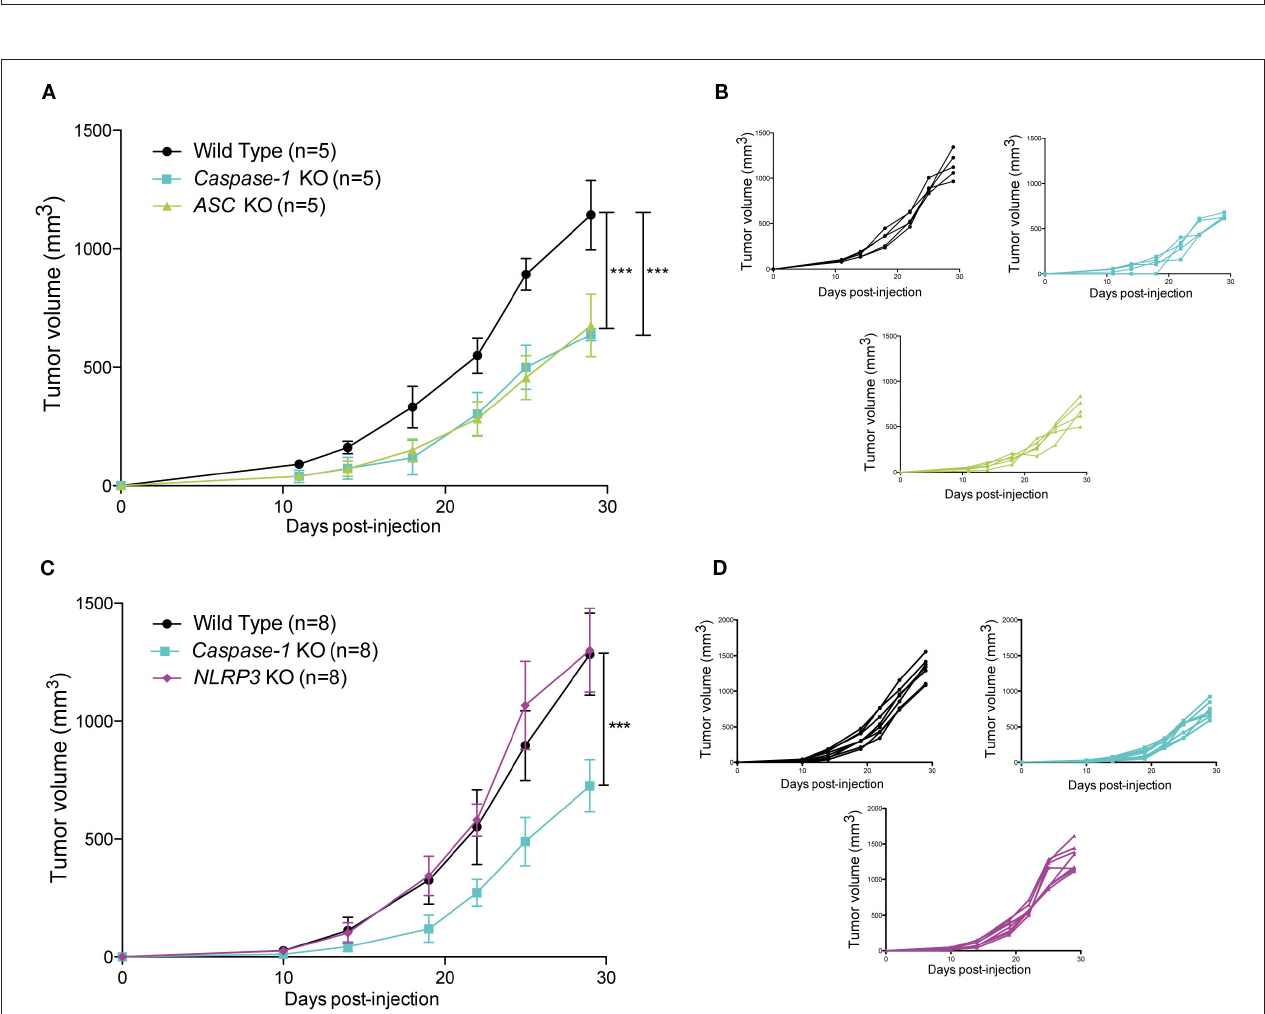
FIGURE 2 | Loss of caspase-1 and ASC expression reduces 4T1 tumor growth in BALB/c mice. (A) WT, Caspase-1 KO, and Asc KO mice ( n = 5) were injected orthotopically with 4T1 mammary tumor cells. Tumor growth was measured over 30 days. (B) Individual growth curves depicted in A. (C) WT, Caspase-1 KO, and Nlrp3 KO mice ( n = 8) were injected orthotopically with 4T1 mammary tumor cells. Tumor growth was measured over 30 days. (D) Individual growth curves depicted in C. Data represent mean ± SD *** P < 0.001 (Two-way ANOVA analysis; n.s, non-significant).